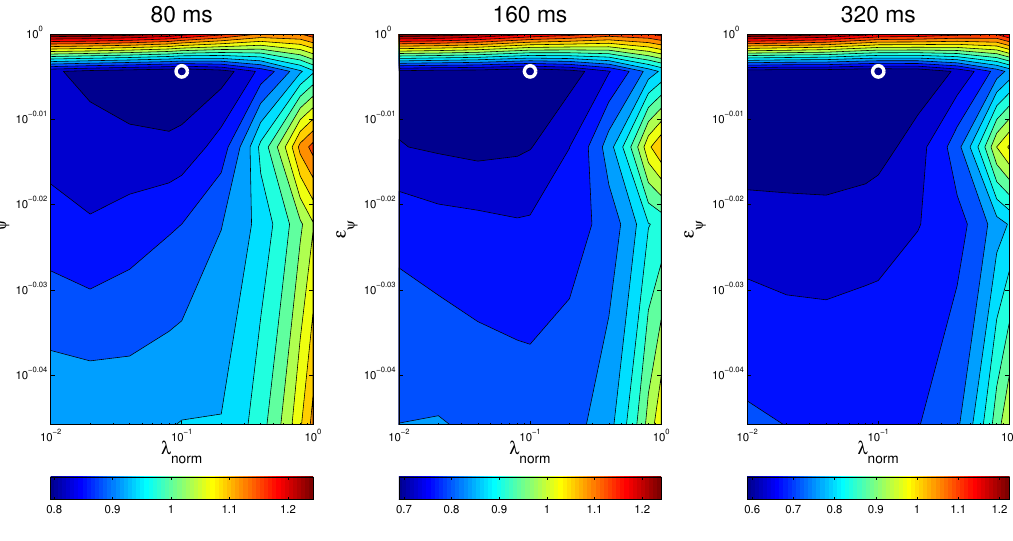
Figure 11. Optimization map for microphone setup A on sequence seq01 . The circle is the position of the best parameter